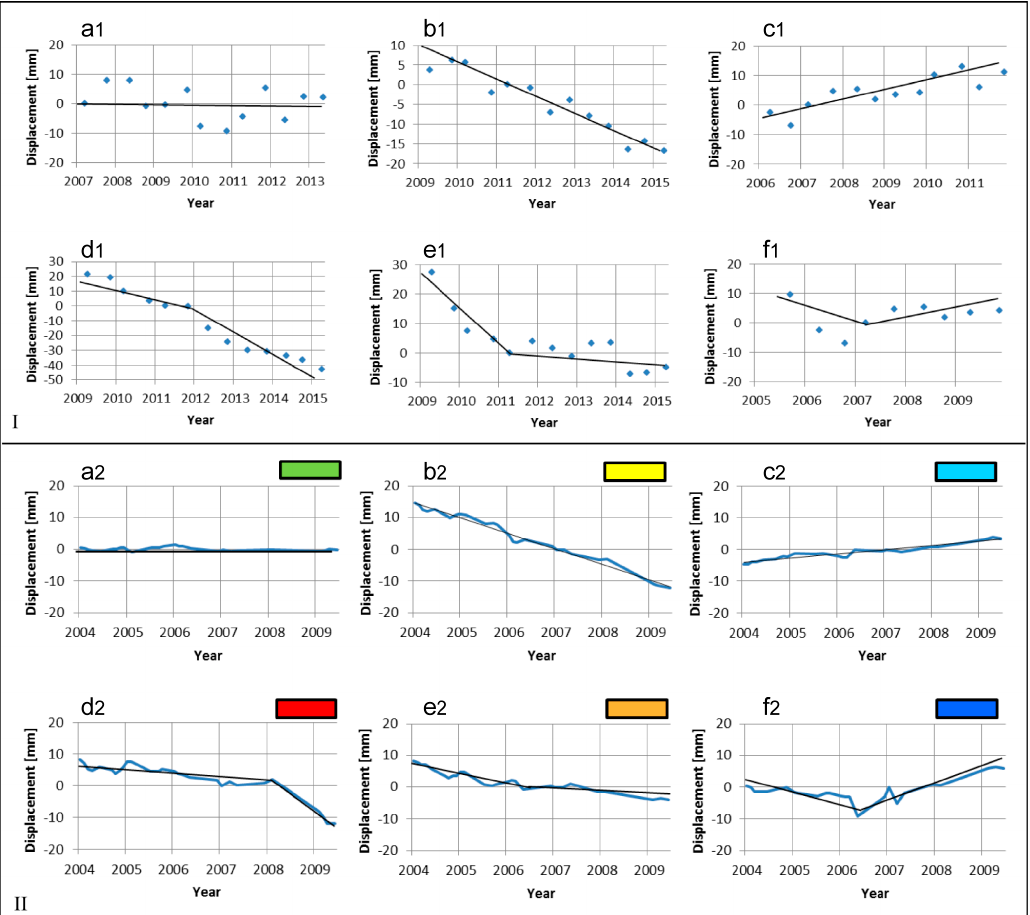
Figure 4. Graphs showing the patterns used to identify the six deformation trend classes used in our model: ( a1 , a2 ) stable; ( b1 , b2 ) deforming linearly downhill; ( c1 , c2 ) deforming linearly uphill; (d1 , d2 ) accelerating downhill; ( e1 , e2 ) decelerating downhill; ( f1 , f2 ) with discontinuous rate and trend. Sub-figures ( a1 – f1 ) represent the patterns of deformation recorded by GNSS benchmarks and projected along the LOS; sub-figures ( a2 – f2 ) show the time series measured with the interferometric analysis at ENVISAT PS locations.